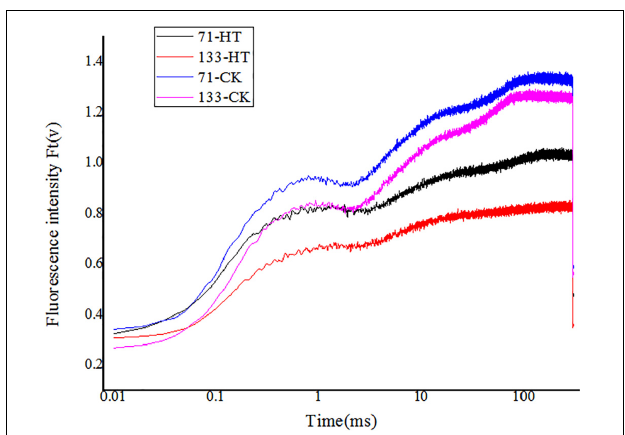
FIGURE 3 | Alterations of chlorophyll fluorescence transients (OJIP curve) in tall fescue leaves in heat-sensitive genotype “TF133” and heat-tolerant genotype “TF71” under normal conditions or heat stress. CK was the control (22/18 ◦ C for light/dark), while HT was the heat treatment (40/35 ◦ C for light/dark). All the plants were treated for 1 day. Mean ± SD were calculated from five biological repeats. Different letters indicated statistical difference significance at P < 0.05 among the different treatments groups by Duncan’s multiple range tests.